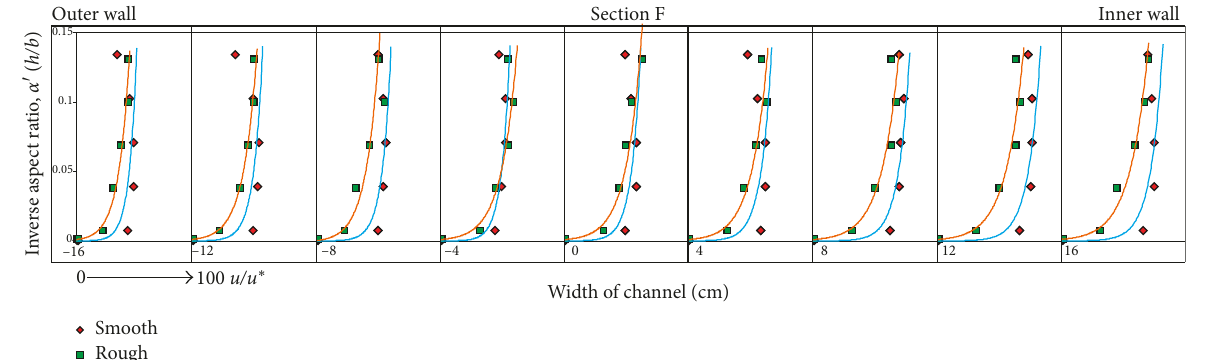
Figure 9: Comparison of velocity variation in section